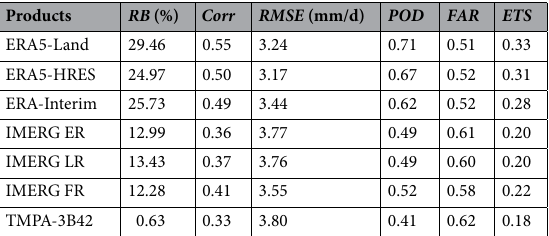
Table 2. Summary of evaluation metrics for the precipitation products for the whole study period.